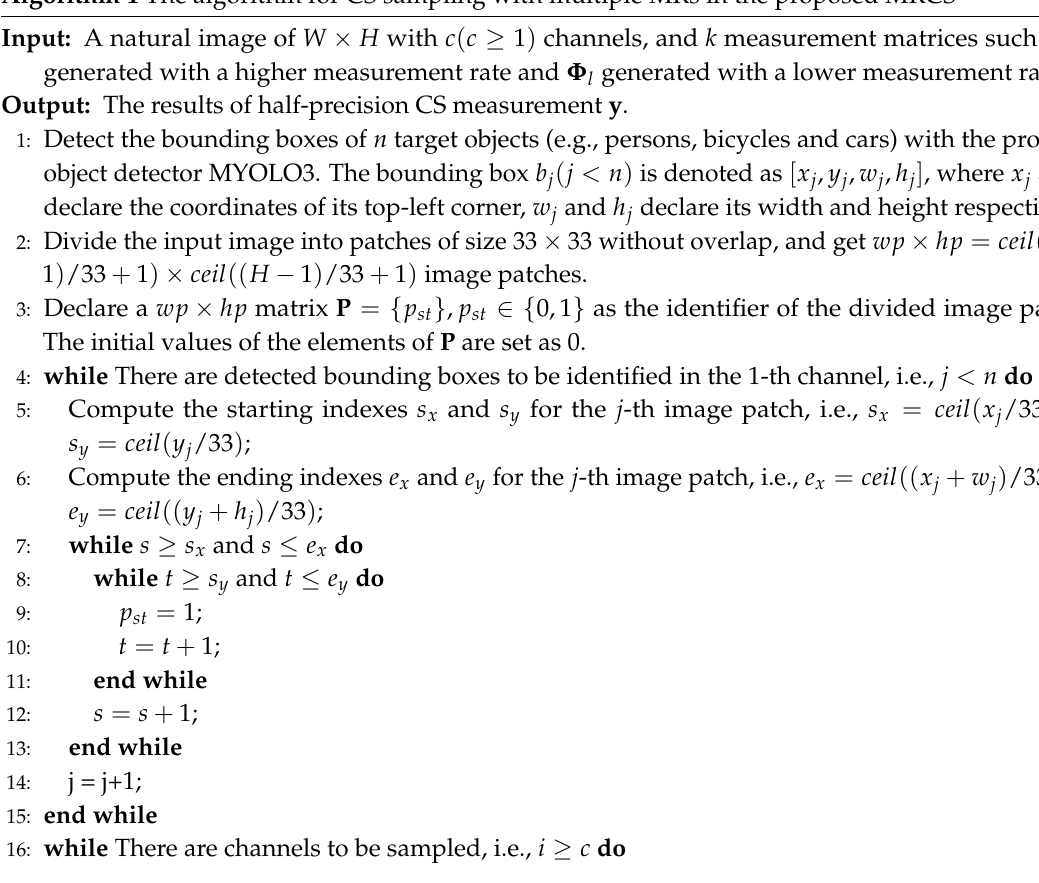
Algorithm 1 The algorithm for CS sampling with multiple MRs in the proposed